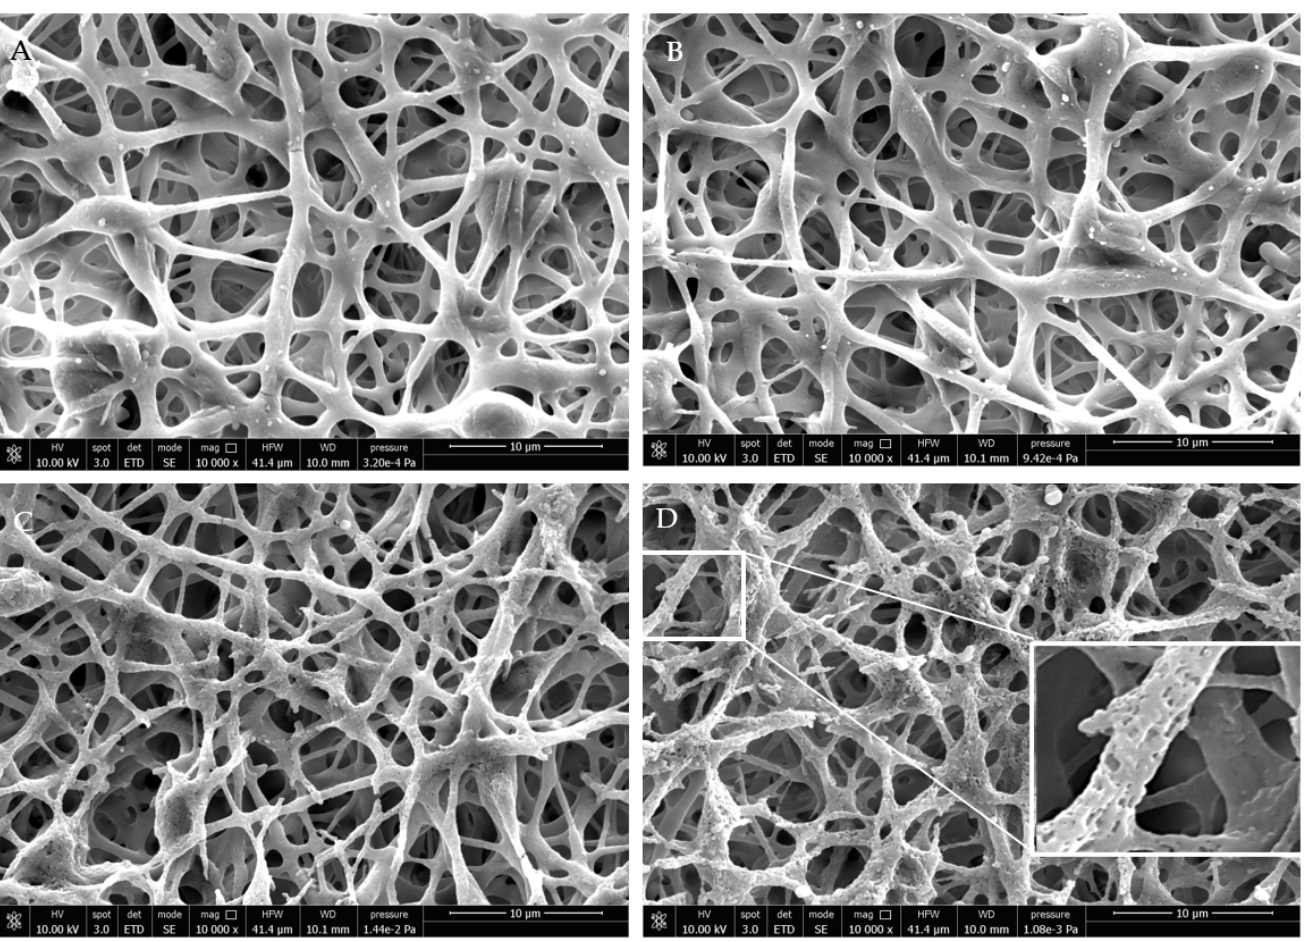
Figure 5. SEM micrographs of PHBHV/OLE under degradation in PBS for ( A ) 2 weeks, ( B ) 4 weeks, ( C ) 6 weeks, and ( D ) 8 weeks. Lens in ( D ) shows evidence of pore formation on the fiber surfaces. Scale bar is 10 µm, 10,000× magnification, 10 kV voltage.